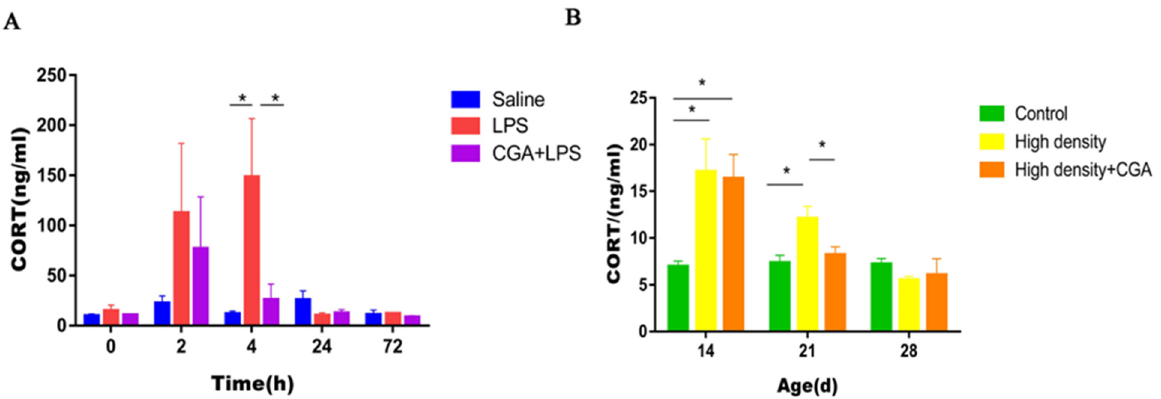
Figure 2. Effects of chlorogenic acid on serum corticosterone concentrations of broilers challenged with immune stress and high density stress. ( A ) Serum corticosterone concentrations after immune stress. ( B ) Serum corticosterone concentrations after high density stress. * means significant difference between groups.